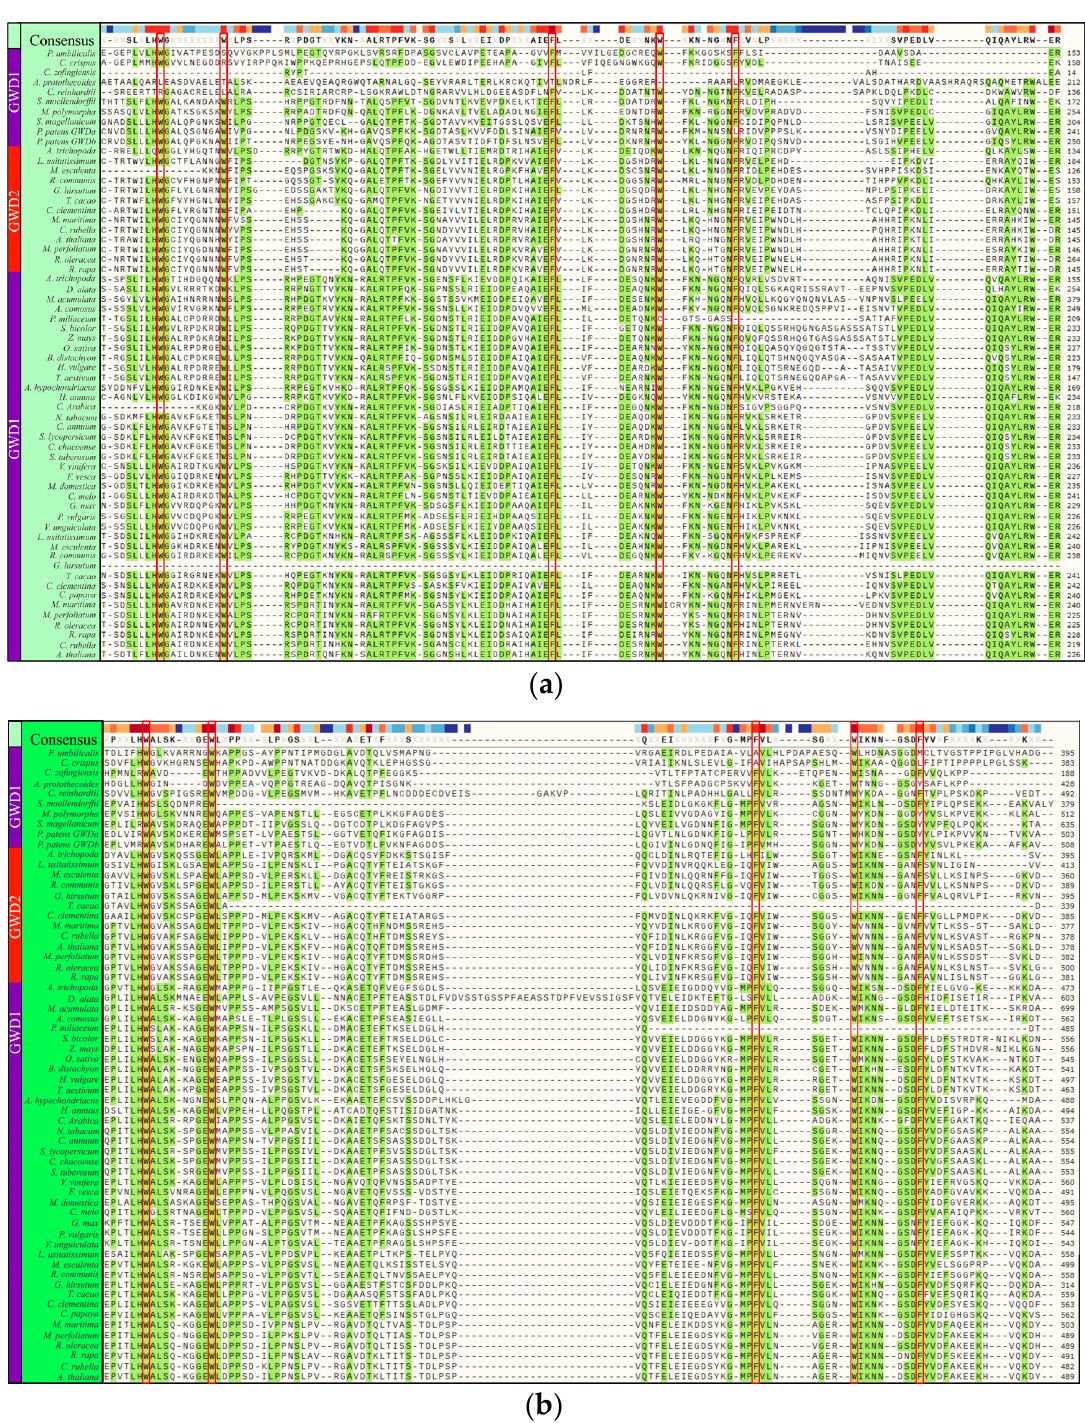
Figure 2. ( a ) Multiple sequence alignment of the first tandem carbohydrate binding module (CBM45-1) showing the five consensus aromatic residues (W, W, F, W, F, respectively) associated with starch binding. The five conserved aromatic amino acids in the (CBM45-1) are highlighted in red. ( b ) Multiple sequence alignment of the second tandem carbohydrate binding module (CBM45-2) showing the five consensus aromatic residues (W, W, F, W, F, respectively) associated with starch binding. The five conserved aromatic amino acids in the (CBM45-2) are highlighted in red.